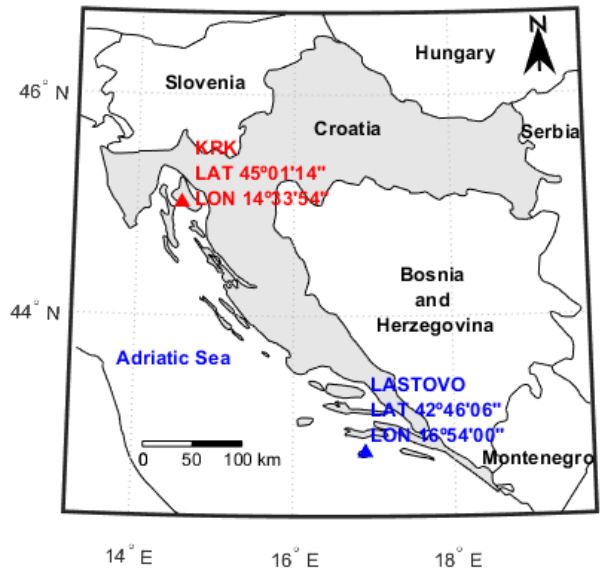
Figure 1. Study area location map.